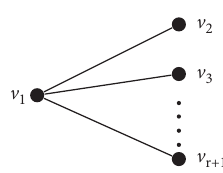
Figure 8: Star graph S